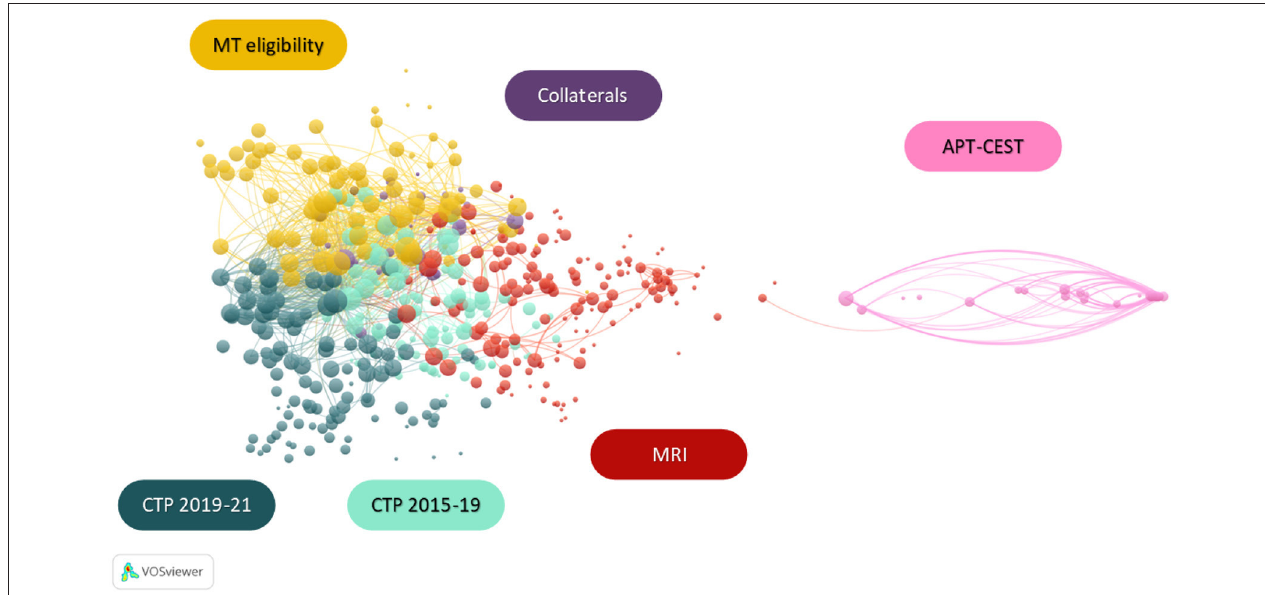
FIGURE 6 | Bibliographic coupling network in the era of mechanical thrombectomy [2015–2021] with labeled clusters based on predominance of themes within the clusters. MRI, magnetic resonance imaging; CTP, computed tomography perfusion; MT, mechanical thrombectomy; APT, amide proton transfer; CEST, chemical exchange saturation